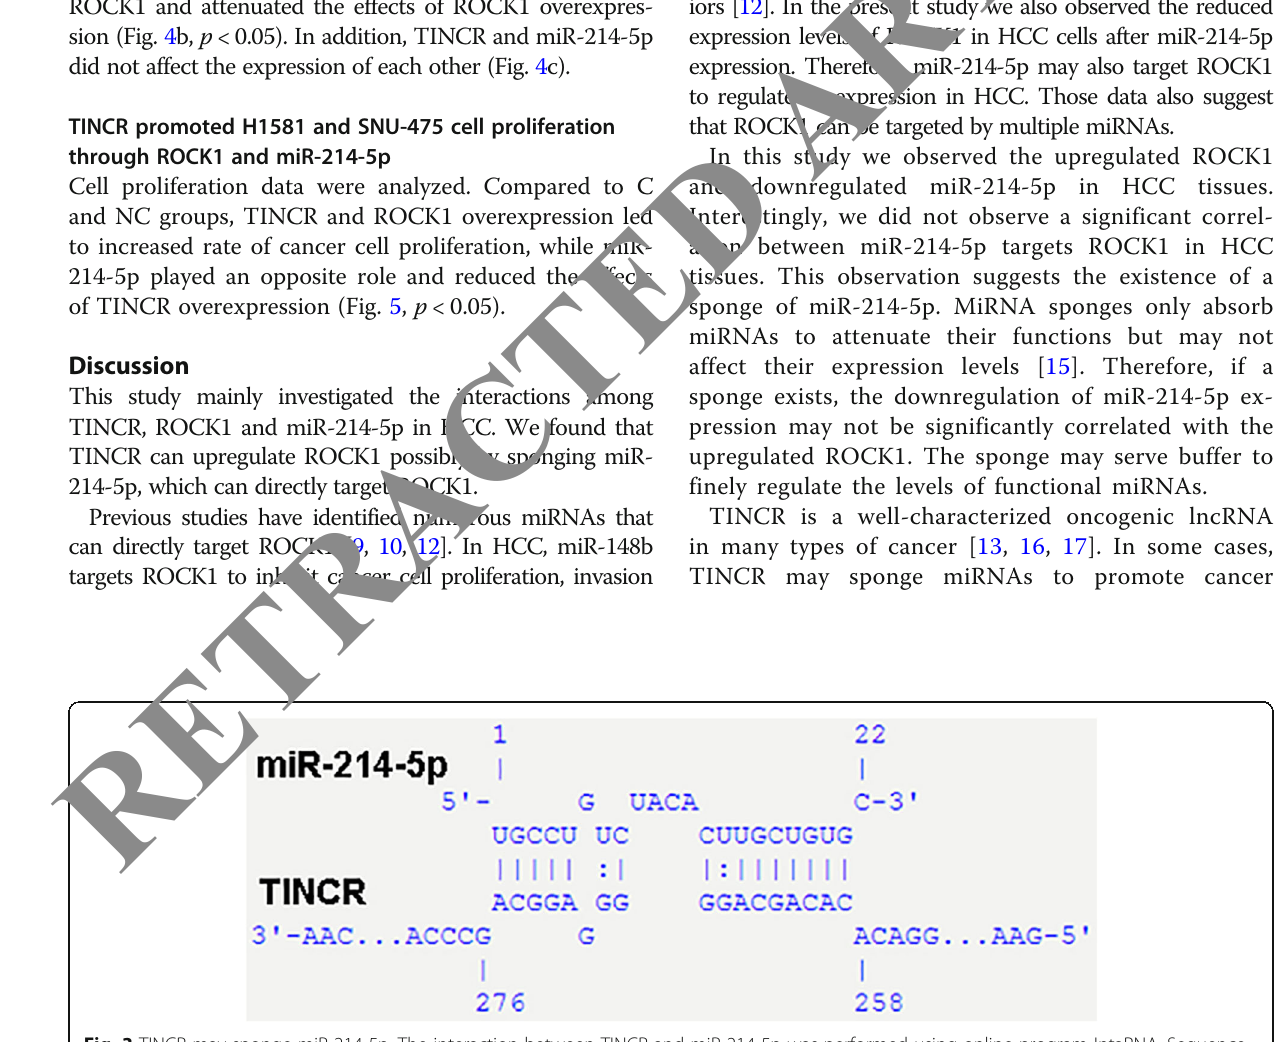
Fig. 3 TINCR may sponge miR-214-5p. The interaction between TINCR and miR-214-5p was performed using online program IntaRNA. Sequence of TINCR was used as the long sequence and sequence of miR-214-5p was used as the short sequence. All other parameters were